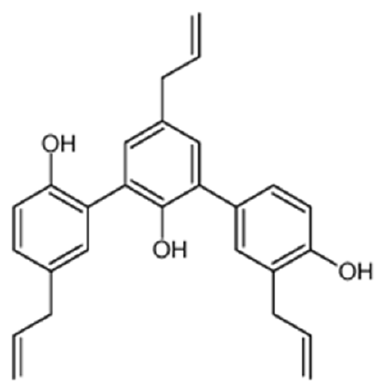
Figure 1. Structure of simonsinol.